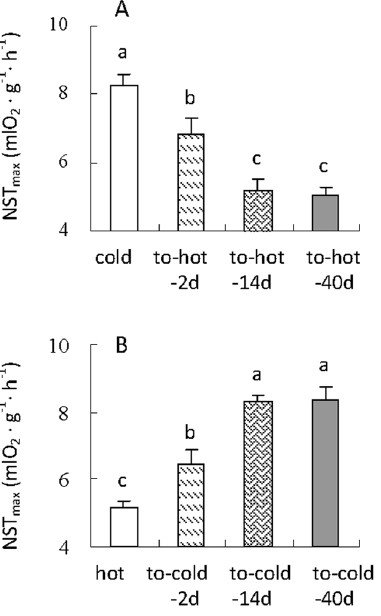
Figure 4. NST max of striped hamsters during the transition of cold to hot (A) and hot to cold condition (B). Different letters (a, b or c) above the columns indicate significant difference between the four groups under same temperature ( P , 0.05). Data are means 6